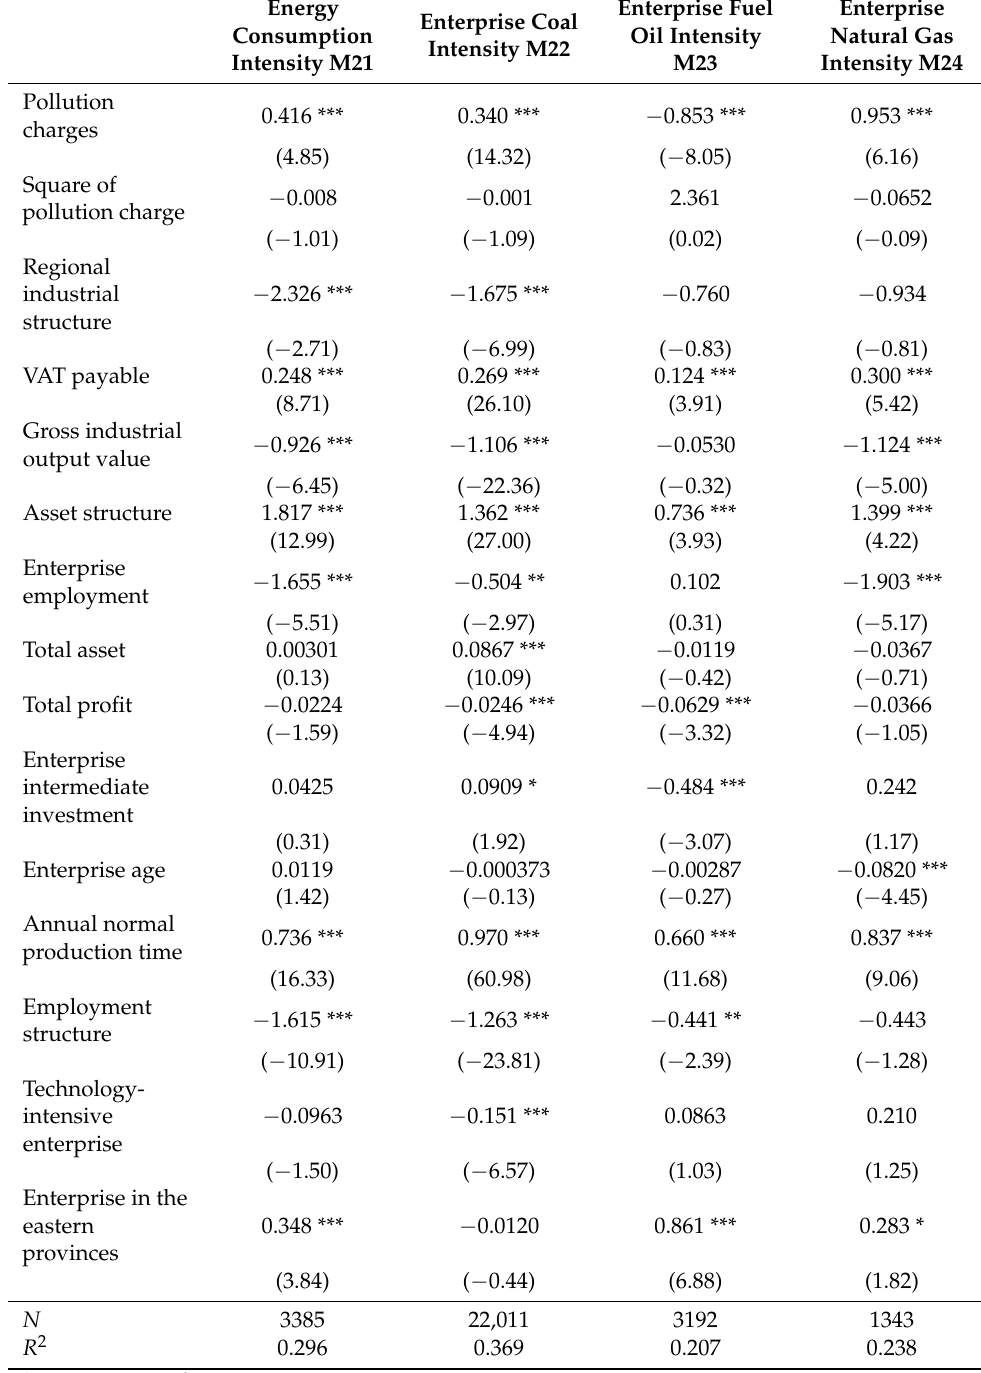
Table 8. Regression results of the impact of pollution charges on enterprises’ energy-saving techno- logical innovation in